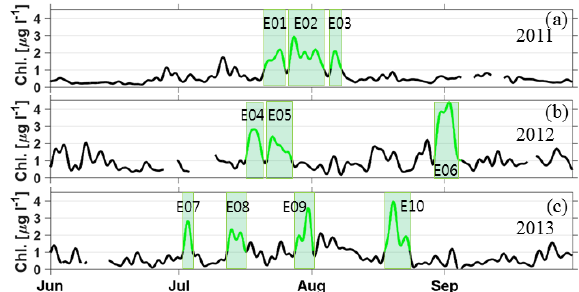
Figure 4. Time series of low-pass-filtered (cutoff period of 40h) chlorophyll fluorescence observed at ESROB during the three sum- mers (JJAS) of (a) 2011, (b) 2012 and (c) 2013. The episodic bloom events are shaded in green and labeled E01 to